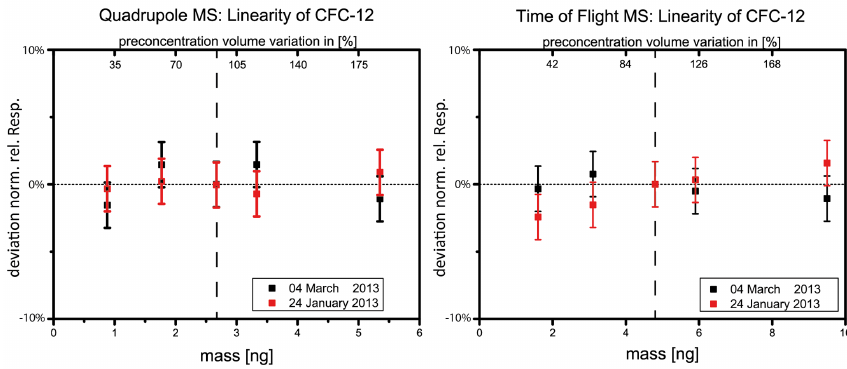
Figure 7. Same figure as Fig. 6 for the substance CFC-12 (CF 2 Cl +